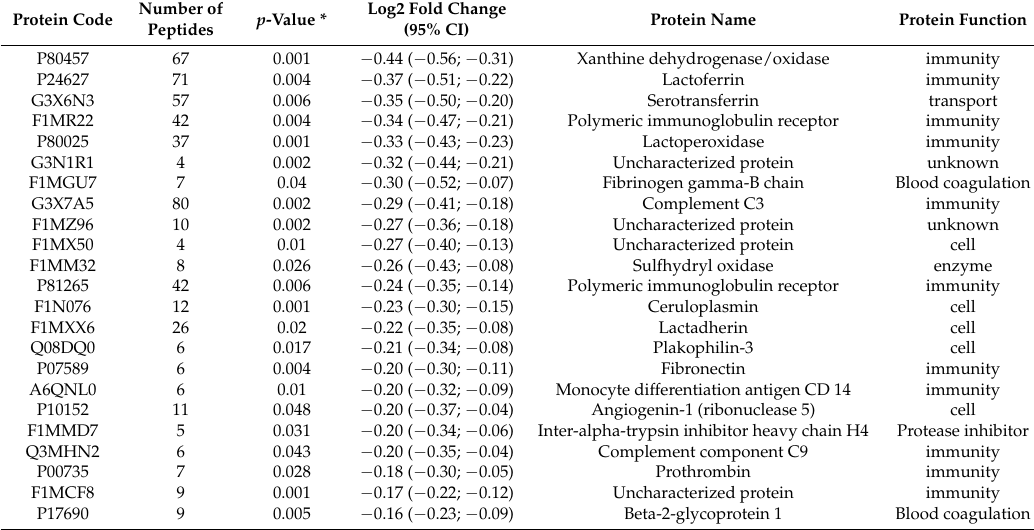
Table 3. Significantly differing proteins between high and no/low heat treated milk-types with a change of ≥